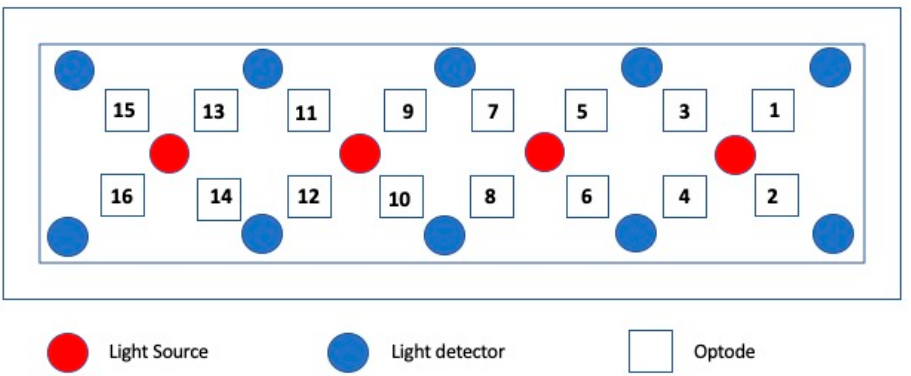
Figure 2. Functional near-infrared spectroscopy (fNIRS) sensor layout with 16 optodes.